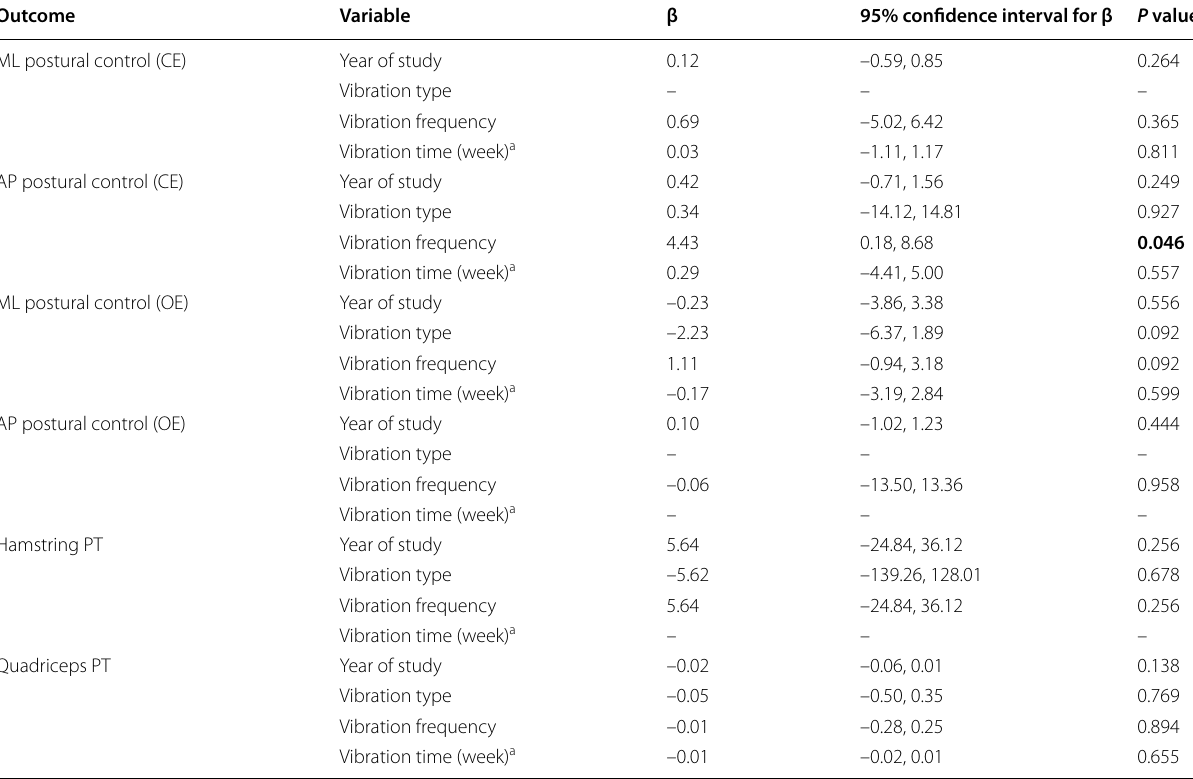
PT peak torque, AP anterioposterior, ML mediolateral, CE closed-eye, OE open-eye a Time interval from surgery to